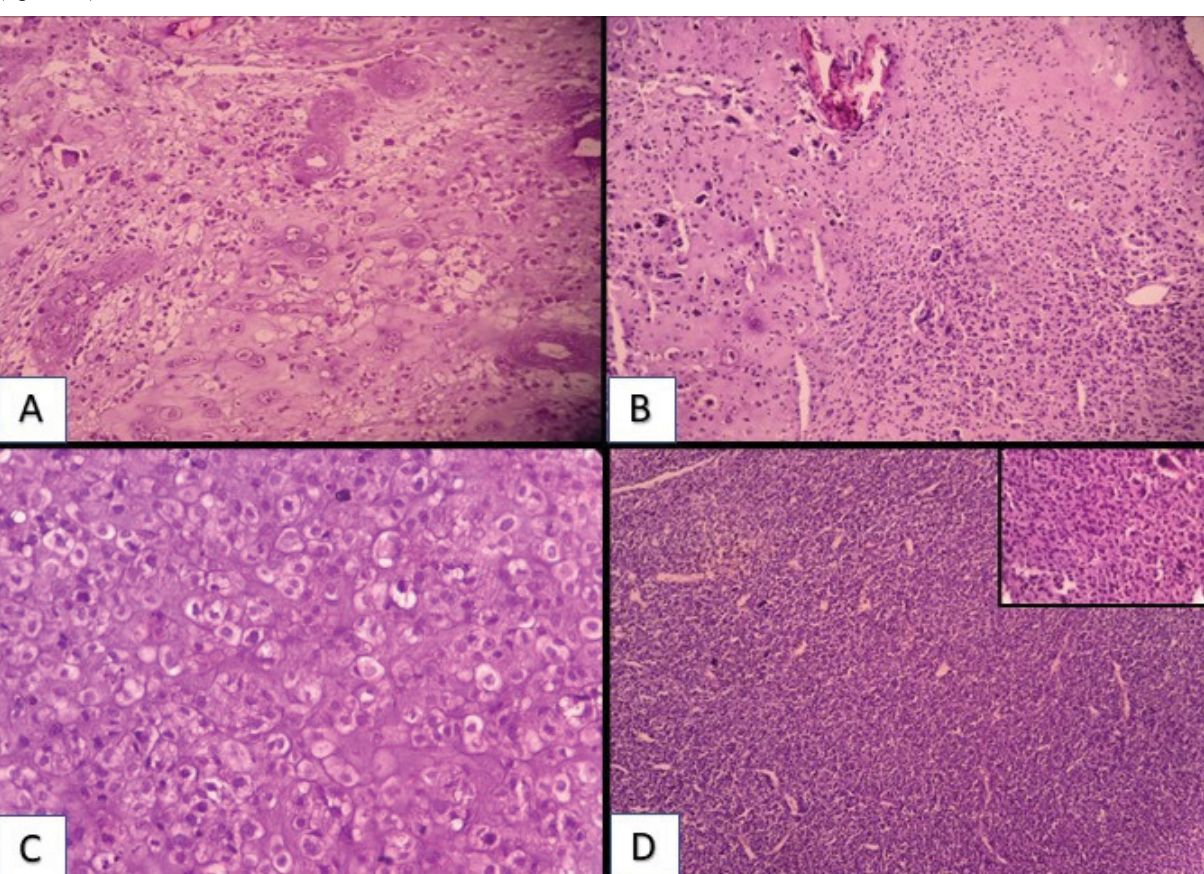
Figure 3: A) Lobules of malignant cartilage with areas with vascular proliferation B)Lobule of cartilage containing malignant chondrocytes surrounded by malignant tumor cells with areas of vascular proliferation. Also seen are multinucleated giant cells and coarse calcification of cartilaginous lobule. C) Malignant chondrocytes on high power. D) Small malignant cells with areas of hemangiopericytoma like vascular proliferation. An inset on top shows high power image of malignant tumor